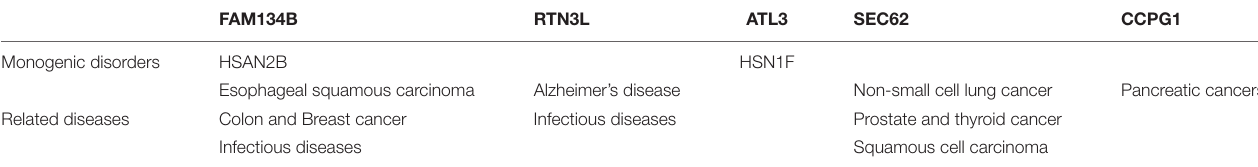
TABLE 1 | Diseases correlated to mutation in different ER-phagy receptors. FAM134B RTN3L ATL3